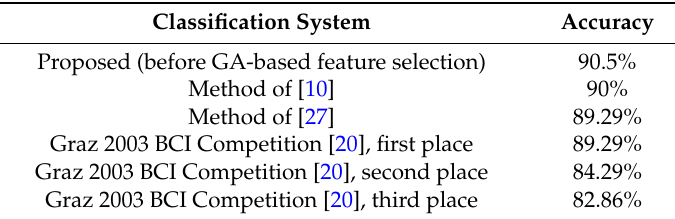
Table 4. Comparison of testing accuracy with different systems. BCI: brain-computer interface. GA: genetic algorithm.